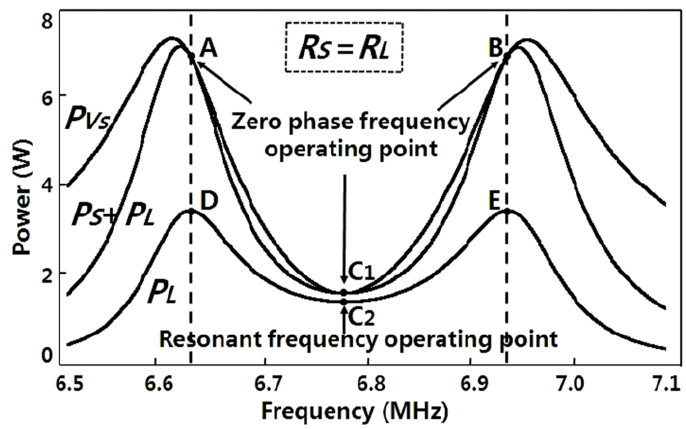
Figure 2. Frequency splitting phenomenon in SCMR and